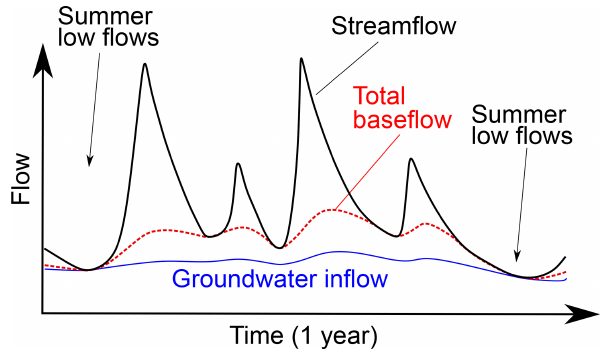
Figure 1. Conceptualization of baseflow. Over the water year, base- flow may dominate streamflow during successive low-flow periods; however, groundwater inflows may be dominant only during low summer flows. Both the groundwater inflows and total baseflow are conceived to vary